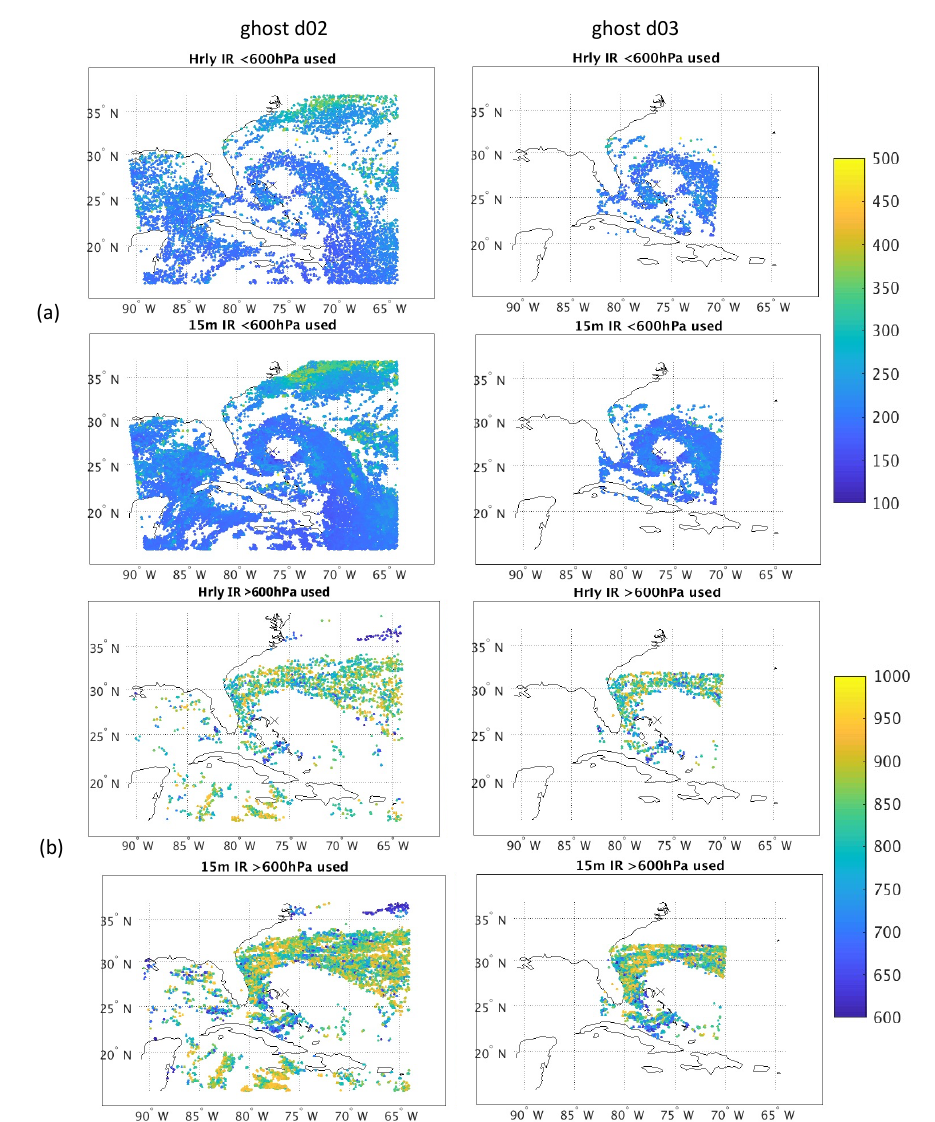
Figure 7. Spatial coverage of IR AMVs for a single assimilation cycle from 2019 Hurricane Dorian on 1 September 2019 at 12 UTC for two HWRF assimilation domains. ( a ) AMVs above 600 hPa for hourly and 15 min AMVs. ( b ) AMVs below 600 hPa for hourly and 15 min AMVs. Height of the AMVs are color coded in hPa. ”X” indicates the center of the storm defined by NHC’s best track. There is a significant increase in the number of 15 min compared to the hourly AMVs, providing better spatial coverage of the model wind field. Temporal information inherent in the high temporal AMVs are not exploited because HDAS is a 3DVAR system. Instead, the 15 min AMVs contribute to spatial regions where hourly AMVs are missing. This includes areas near the center of the storm (Figure 7a). The lack of AMVs close to the tropical cyclone center is due to the limits of the AMV generation by the data provider and is caused by extreme changes in target direction and speed between images. The other four AMV types (figures not shown) show a similar pattern.